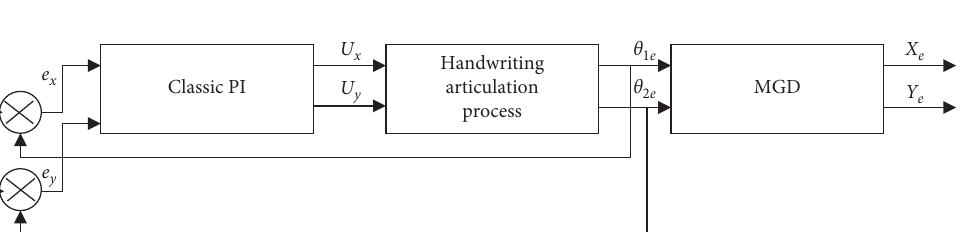
Figure 9: Application of the classic PI